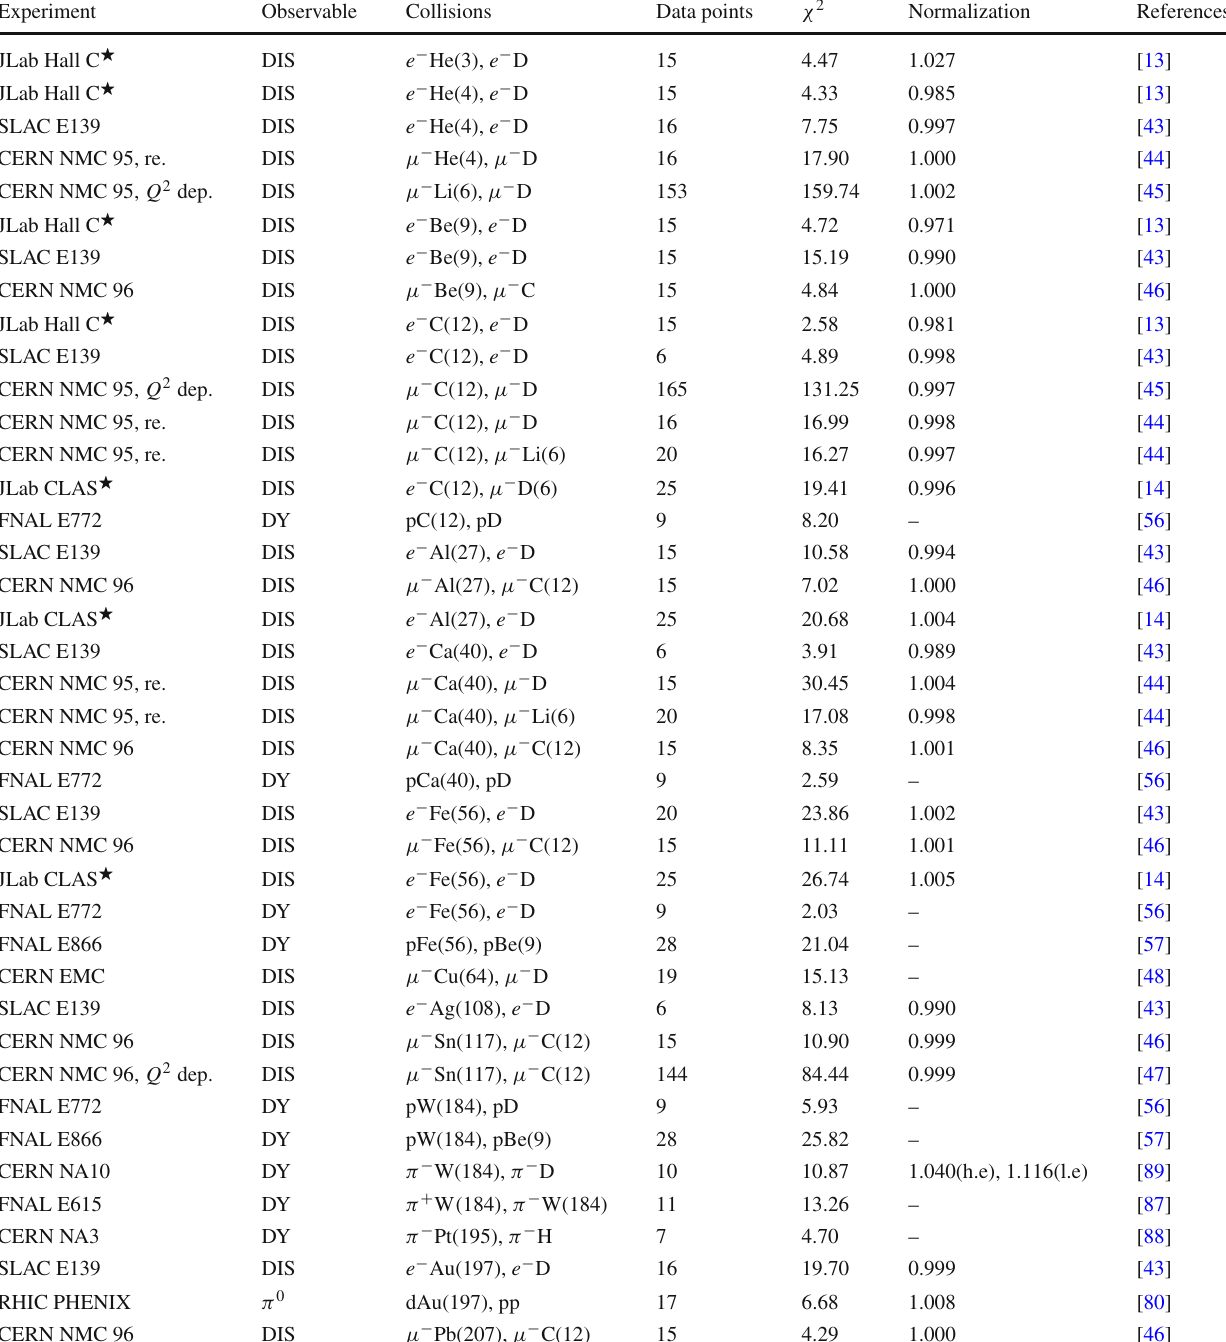
Table 2 The data used in the EPPS21 analysis. The new data with respect to the EPPS16 analysis are marked with a star